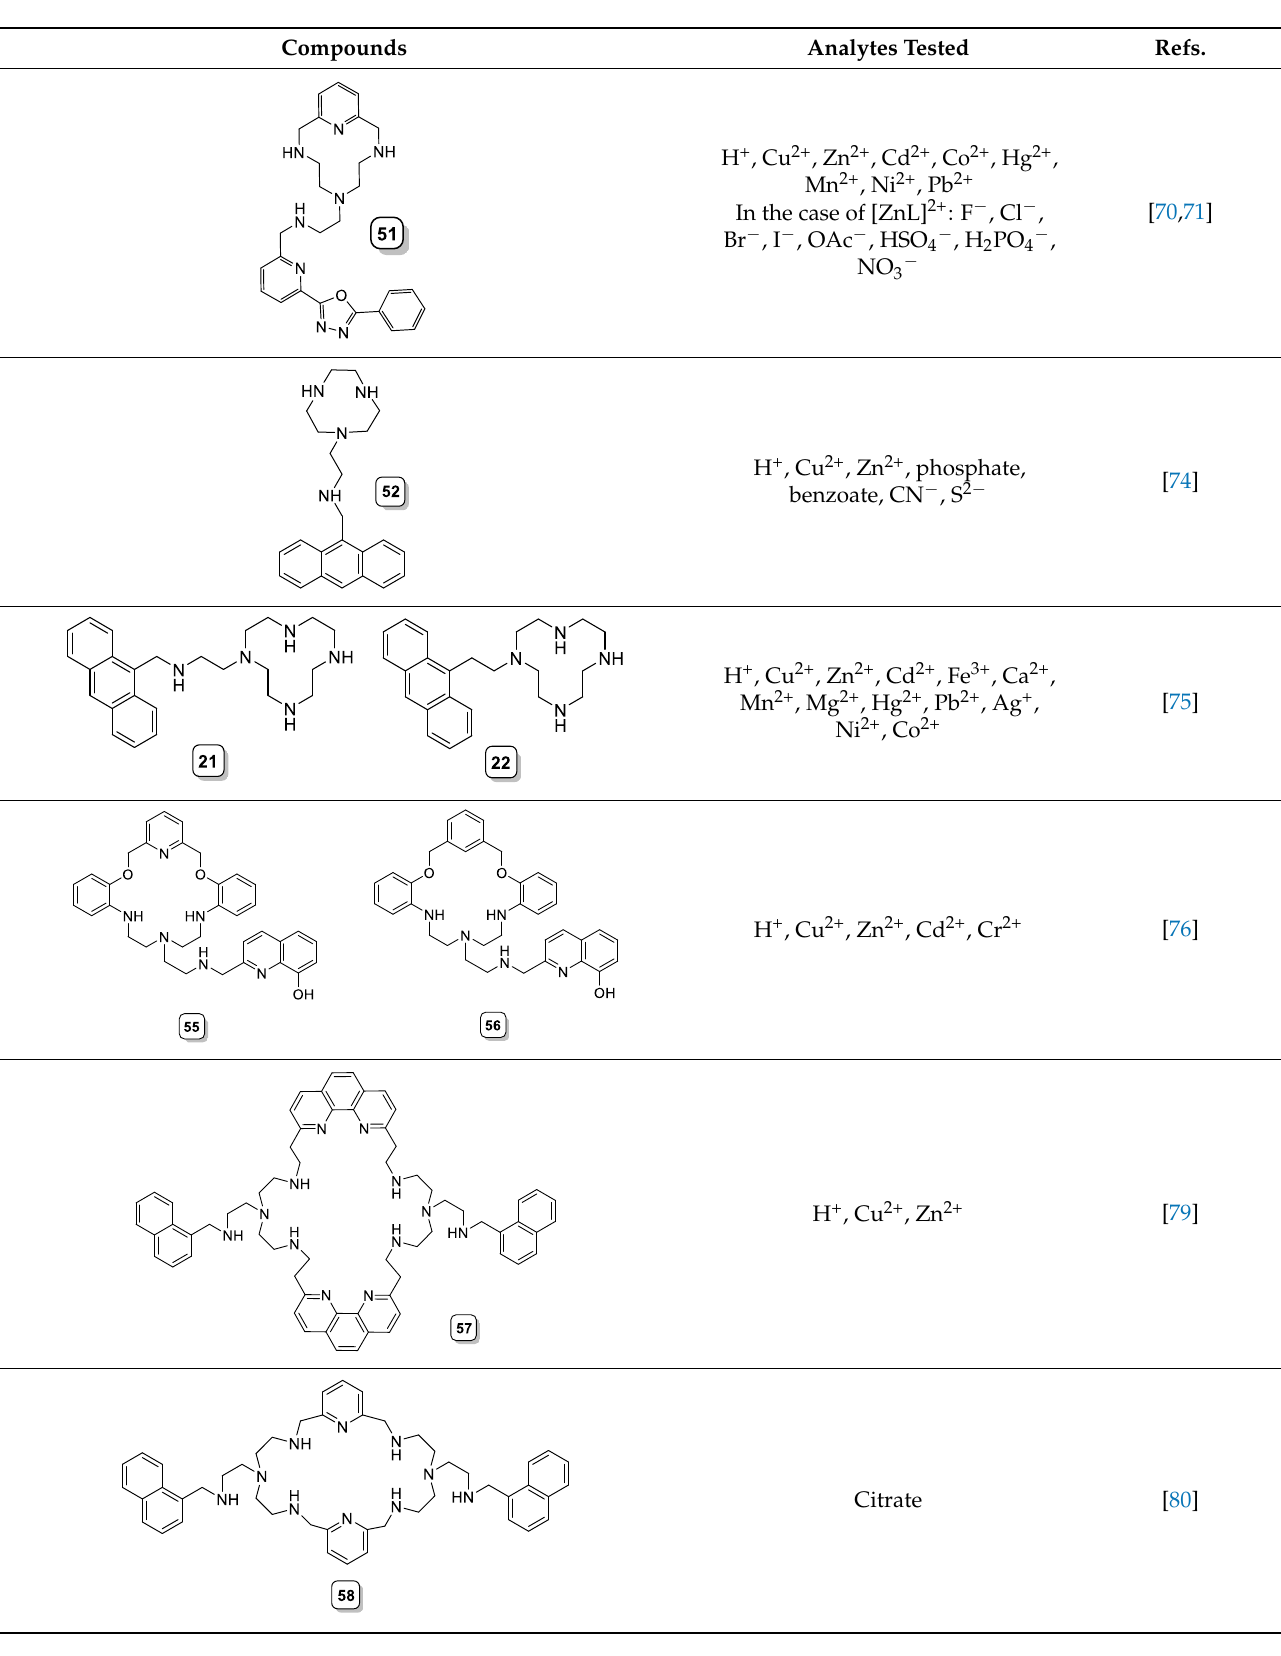
Table A1. Cont. Compounds Analytes Tested